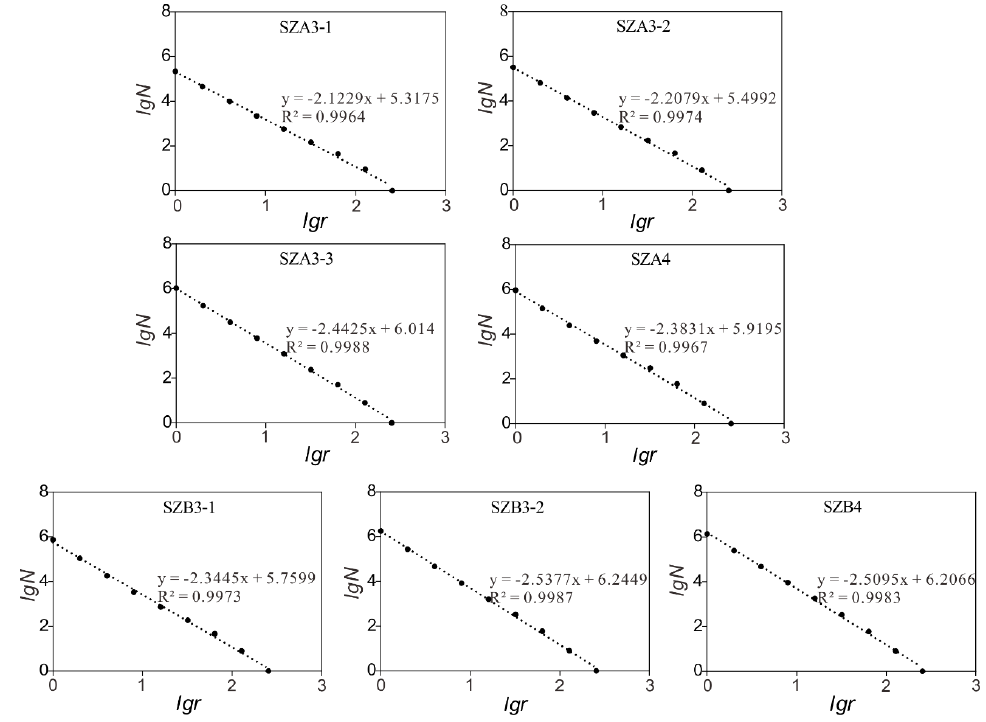
Figure 15. The lgN - lg r scatter plot at different load stages of each specimen (A3-1: SZA3 at σ 1 = 79.58 MPa, A3-2: SZA3 at σ 1 = 103.45 MPa, A3-3: SZA3 at fractured; B3-1: SZB3 at σ 1 = 103.45 MPa, B3-2: SZB3 at fractured).